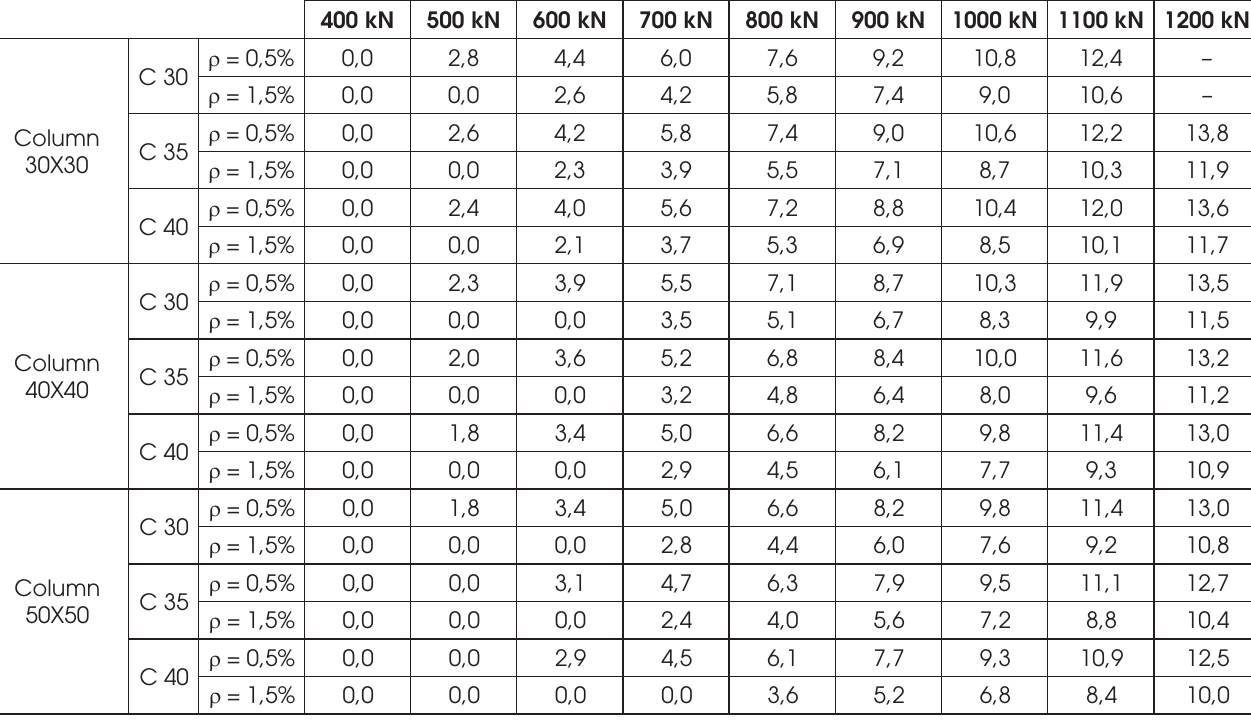
Area of shear reinforcement (cm²) by NBR 6118:2007 (analysis 1)